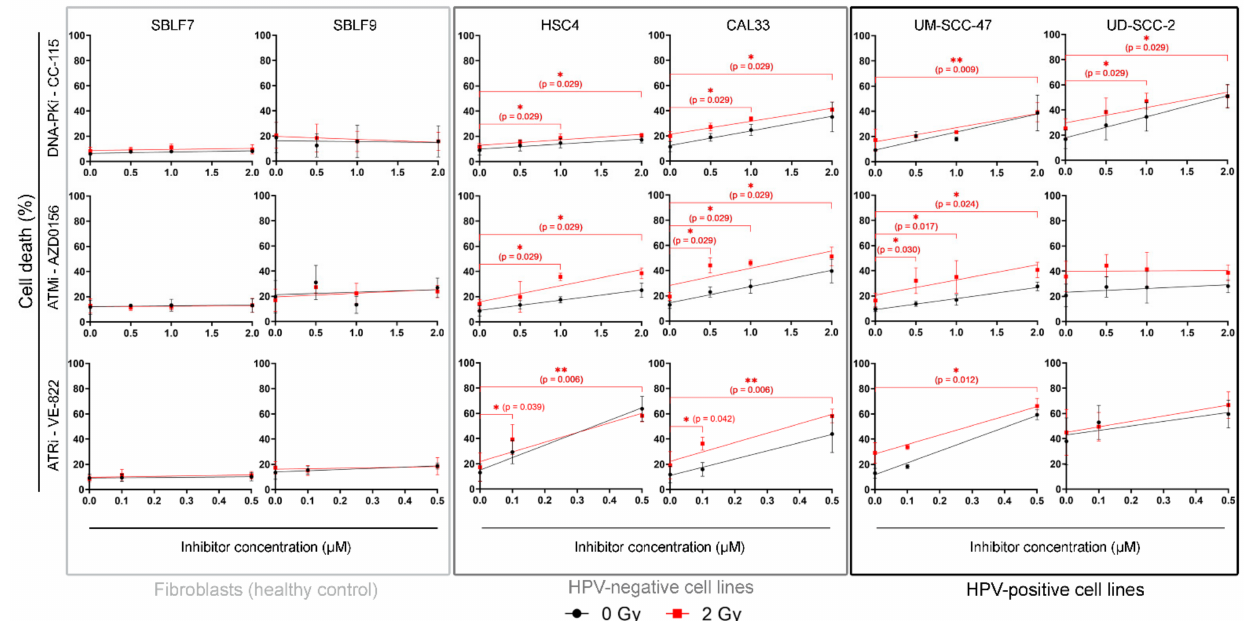
Figure 2. Flow cytometry analysis of cell death. Cells are grouped into normal donor cells (SBLF7, SBLF9), HPV-negative (HSC4, CAL33), and HPV-positive (UM SCC 47, UD SCC 2) HNSCC cell lines. Cell death was determined through flow cytometry by apoptosis (Annexin V) and necrosis (7AAD) detection. Irradiated samples are compared to non-irradiated samples. Effects of increasing concentrations of kinase inhibitors on each cell line are shown. For CC 115 and AZD0156 0.5, 1 and 2 µ M, for VE 822 0.1 and 0.5 µ M of the inhibitor were used. Each value represents mean ± SD ( n ≥ 3). Significance was determined by two-tailed Mann Whitney U test * p ≤ 0.05 and ** p ≤ 0.01.